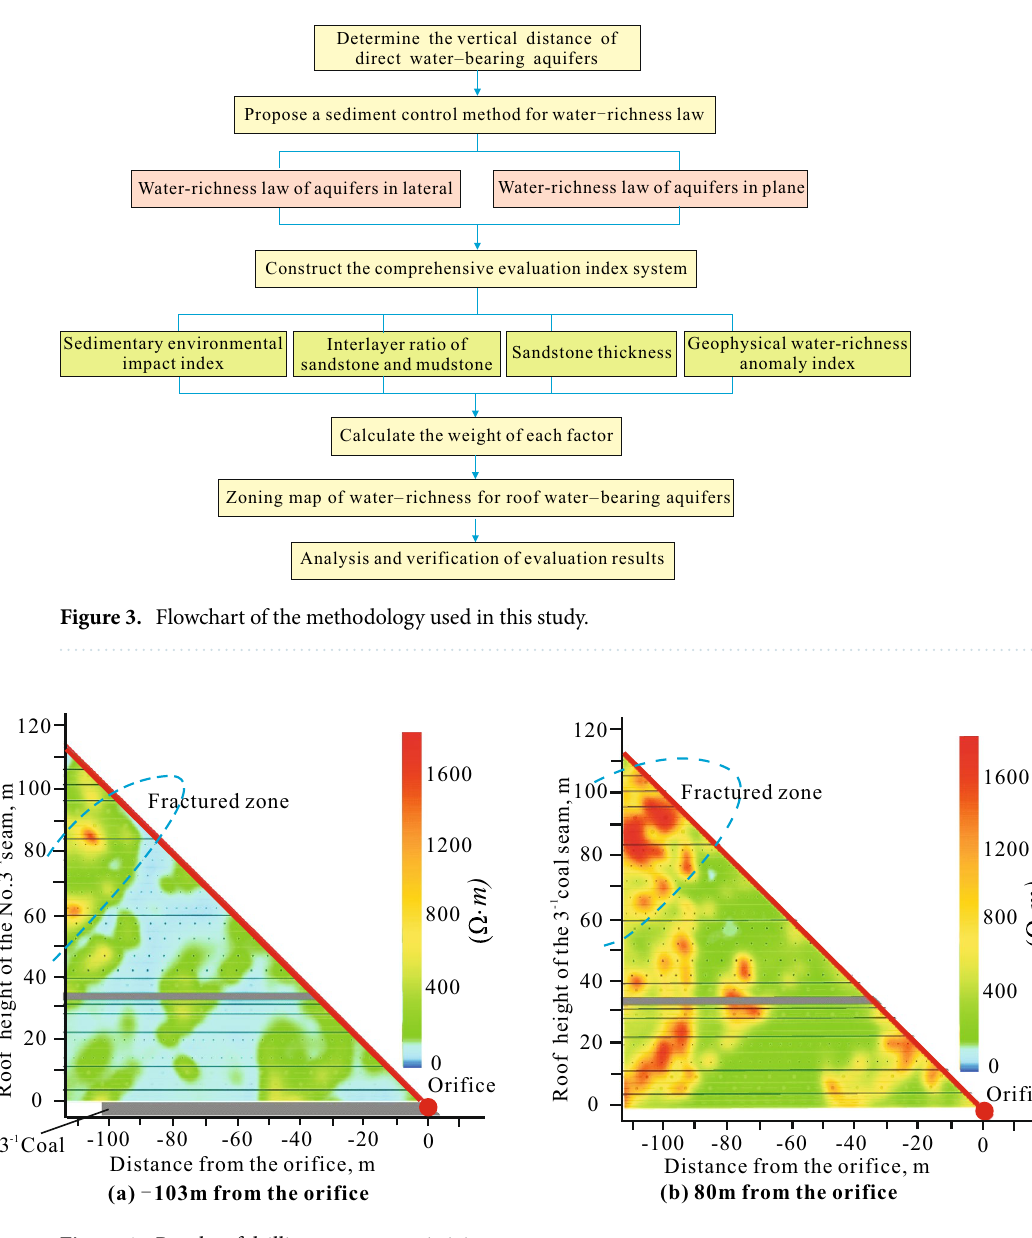
Figure 4. Results of drilling apparent